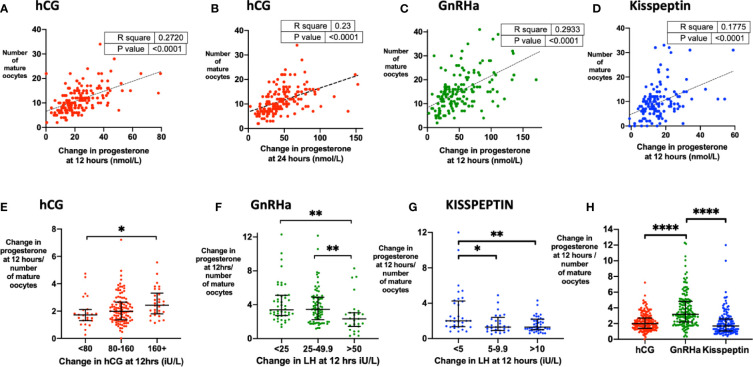
Progesterone rise during oocyte maturation. (A) Change in progesterone at 12 h (nmol/L) after hCG trigger predicted the number of mature oocytes retrieved by simple linear regression (n= 159). Number of mature oocytes retrieved = 0.204 x change in progesterone at 12 h (nmol/L) + 6.60, r2 = 0.27, P < 0.0001. (B) Change in progesterone at 24 h (nmol/L) after hCG trigger predicted the number of mature oocytes retrieved by simple linear regression (n= 161). Number of mature oocytes retrieved = 0.098 x change in progesterone at 24 h (nmol/L) + 6.8, r2 = 0.23, P < 0.0001. (C) Change in progesterone at 12 h (nmol/L) after GnRHa trigger predicted the number of mature oocytes retrieved by simple linear regression (n= 151). Number of mature oocytes retrieved = 0.133 x change in progesterone at 12 h (nmol/L) + 8.37, r2 = 0.29, P < 0.0001. One outlier has not been shown on the graph. (D) Change in progesterone at 12 h (nmol/L) after kisspeptin trigger predicted the number of mature oocytes retrieved by simple linear regression (n = 143). Number of mature oocytes retrieved = 0.297 x change in progesterone at 12 h (nmol/L) + 4.83, r2 = 0.18, P < 0.0001. (E) Median (IQR) of change in progesterone at 12 h (nmol/L) divided by number of mature oocytes after hCG by categories of change in serum hCG at 12 h (iU/L) (n = 159). Categories were compared by the Kruskal-Wallis test with post-hoc Dunn’s multiple comparison test. (F) Median (IQR) of change in progesterone at 12 h (nmol/L) divided by number of mature oocytes after GnRH by categories of change in LH at 12 h (iU/L) (n = 151). Categories were compared by the Kruskal-Wallis test with post-hoc Dunn’s multiple comparison test. One outlier has not been shown on the graph. (G) Median (IQR) of change in progesterone at 12 h (nmol/L) divided by number of mature oocytes after kisspeptin by categories of change in LH at 12 h (iU/L) (n = 151). Categories were compared by the Kruskal-Wallis test with post-hoc Dunn’s multiple comparison test. (H) Median (IQR) of change in progesterone at 12 h divided by number of mature oocytes after each trigger is presented: hCG (n = 159); GnRHa (n = 151), kisspeptin (n = 137). Categories were compared by Kruskal-Wallis test with post hoc Dunn’s multiple comparison test. Four outliers were not shown on the graph. *P < 0.05, **P < 0.01,****P < 0.0001.